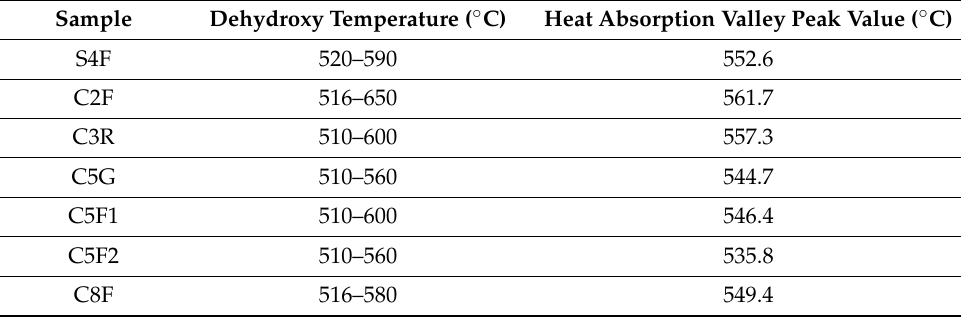
Table 2. Kaolinite rocks’ dehydroxy temperature and heat-absorption valley peak